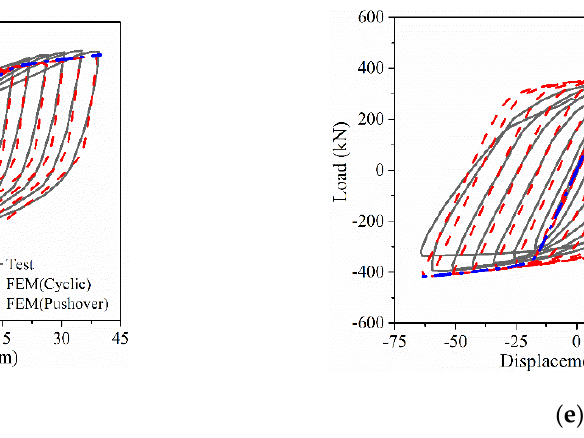
Figure 7. Comparison between numerical and experimental results: ( a ) SPSW − HS2; ( b ) SPSW − HS; ( c ) DS − PSW; ( d ) DS − SPSW; ( e ) frame.